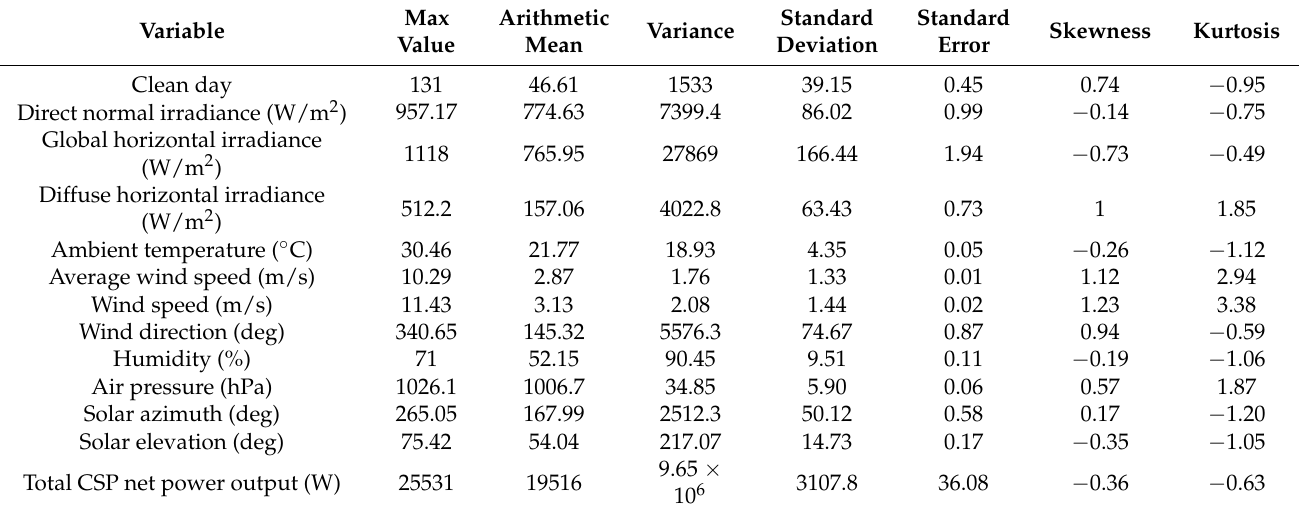
Table 4. Summary of all used statistical